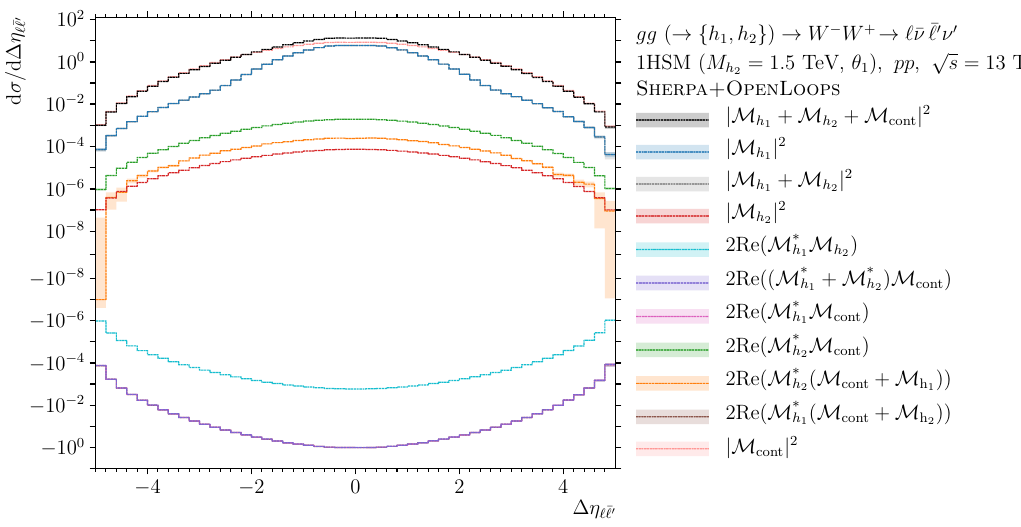
∆ η distributions for the signal process gg ( (cid:31) ¯ (cid:31) (cid:31) = 1500 GeV, θ 1 ) including its interference with the background in pp collisions at the 1HSM ( M h 2 √ s = 13 TeV. Other details as in figure